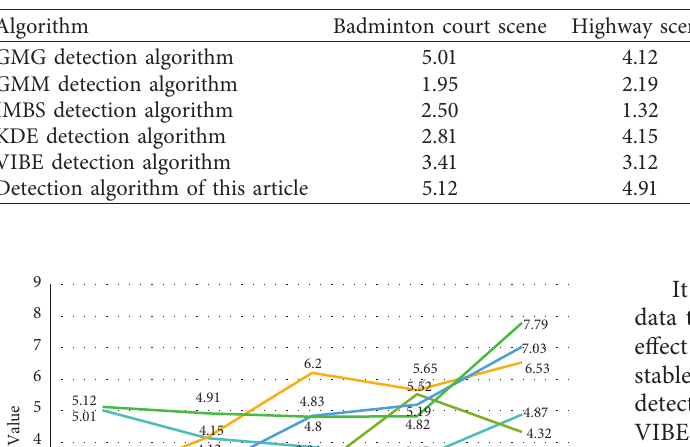
Figure 4: Effect analysis diagram of dynamic background video library scene. Table 4: Effect analysis data of camera shake video library scene.